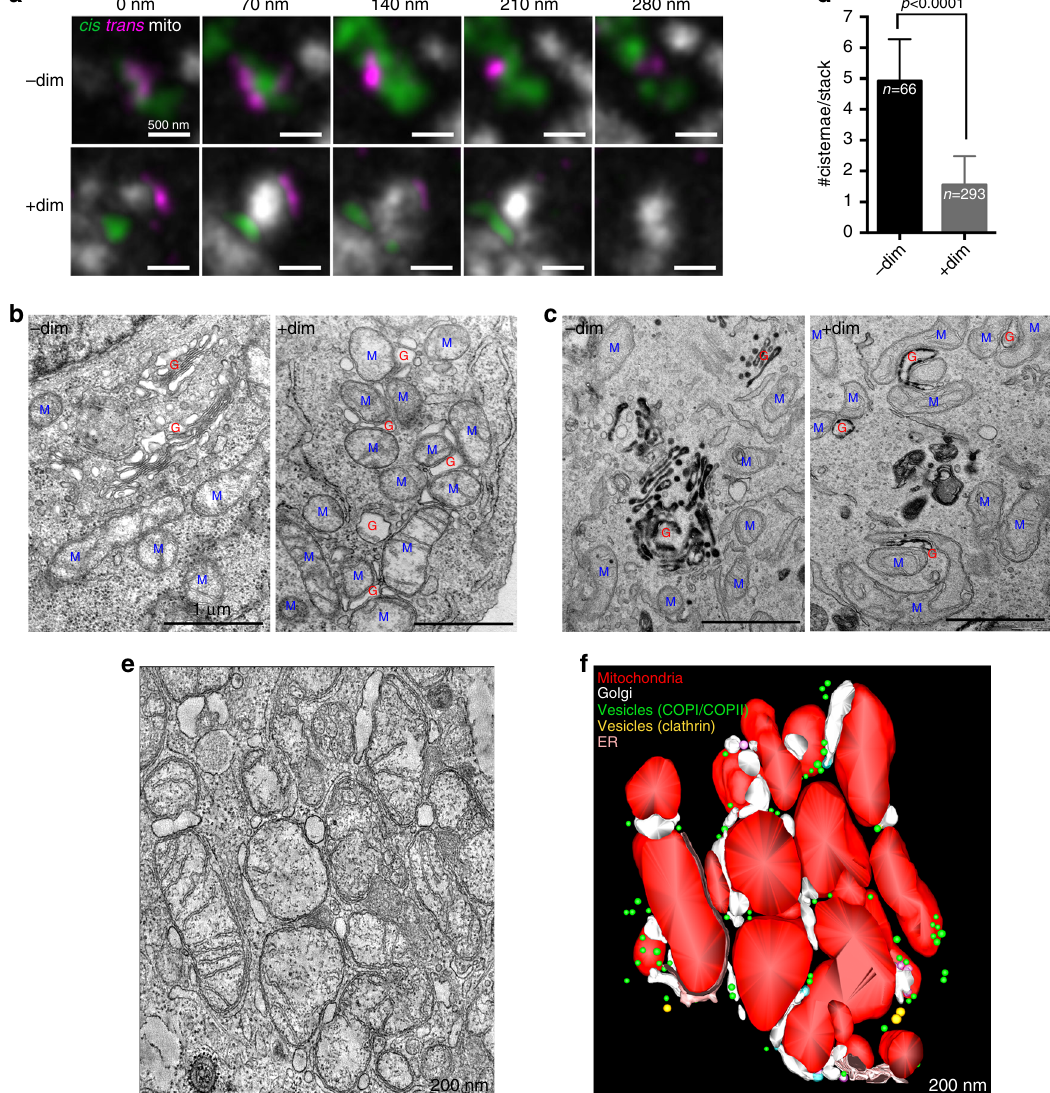
Fig. 2 Land-locked Golgi cisternae are unstacked. a STED microscopy images of serial thin sections of HeLa cells cotransfected with GRASP55-FKBP-HA and FRB-Myc-OMP25 and stained for mitochondria (CMXRos) and immunostained for cis -Golgi (gpp130) and trans- Golgi (p230). Complete separation of cis -cisterna and trans -cisterna is evident only in the presence of the dimerizer. Scale bar is 500 nm. b TEM of HeLa cells transfected with GRASP55-FKBP- BFP and FRB-Myc-OMP25. Blue M indicates mitochondria. Red G indicates Golgi. Scale bar is 1 μ m. c TEM of ManII-HRP HeLa cells transfected with GRASP55-FKBP-BFP and FRB-Myc-OMP25, then treated with DAB and H 2 O 2 post- fi xation to turn Golgi-speci fi c membranes black . Scale bar is 1 μ m. d Quanti fi cation of the number of cisternae/stack in GRASP55 re-targeted HeLa cells from b . e Optical section of an EM tomogram of HeLa cells transfected with GRASP55-FKBP-BFP and FRB-Myc-OMP25, then treated with dimerizer. Scale bar is 200 nm. f A surface-rendered 3D model of EM tomogram from e was generated to visualize the unstacked cisternae of land-locked Golgi. Error bars = s.d. For statistical analysis, t -tests were